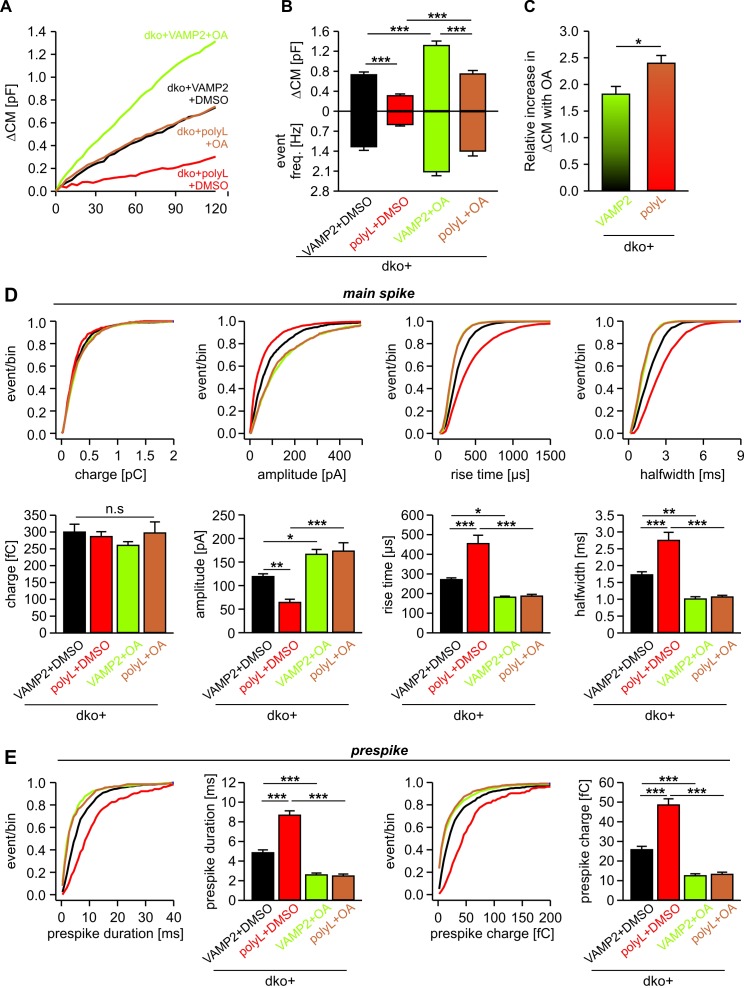
Intracellular OA enhances total exocytosis and reverses the slower release kinetics seen with polyL-TMD mutant.(A) Mean capacitance changes in response to stimulus for the indicated groups. (B) Total ∆CM (top) and amperometric event frequency (bottom) reconfirm that polyL mutant reduces exocytosis. Intracellular application of OA increases secretion both in VAMP2 and polyL expressing cells. (C) Increase in total secretion with intracellular OA relative to DMSO is significantly higher in polyL expressing cell compared to VAMP2. (D, E) Cumulative frequency distributions and cell-weighted averages for the indicated parameters of the spike (D) and the prespike phase (E). Note that intracellular application of OA accelerates the cargo discharge kinetics in VAMP2 expressing cells and overrides the kinetic differences in transmitter release between VAMP2 and the polyL mutant. Values are given as mean of median determined from the indicated parameter’s frequency distribution for each cell. Data were collected from cells/events measured for dko+VAMP2 (18/1071), dko+VAMP2polyL (17/595), dko+VAMP2+LPC (18/2080) and dko+VAMP2polyL+LPC (18/1661). Only cells with >20 events were considered. Data are represented as mean ± SEM. *p<0.05, **p<0.01, ***p<0.001, one-way analysis of variance followed by Tukey-Kramer post test.